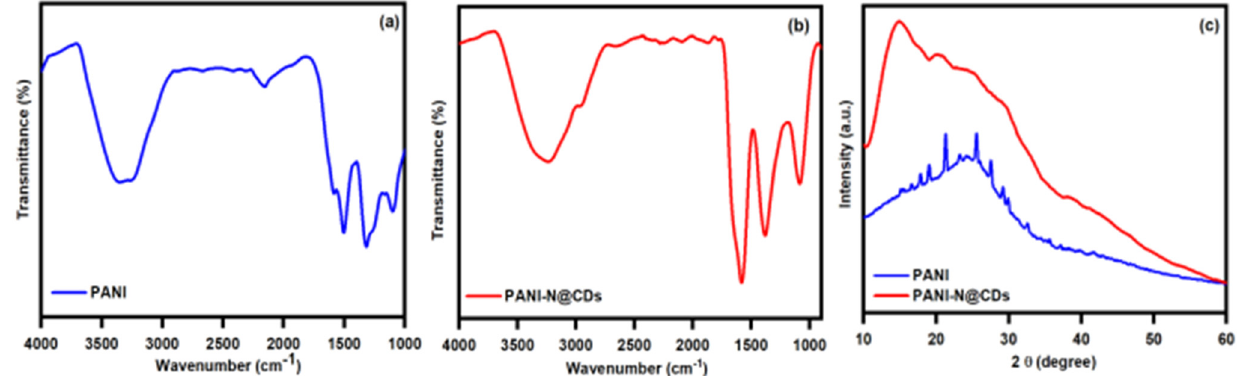
Figure 1. ( a , b ) FTIR spectra of PANI and PANI-N@CDs; ( c ) XRD pattern of PANI and PANI-N@CDs. Table 1. The major functional groups and their corresponding absorption frequency. Material Absorption Region (cm − 1 ) and Functional Groups